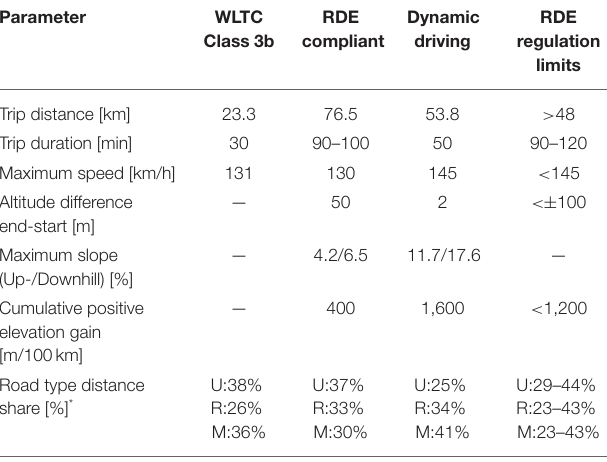
TABLE 3 | Characteristics of the WLTC and the on-road (RDE) test